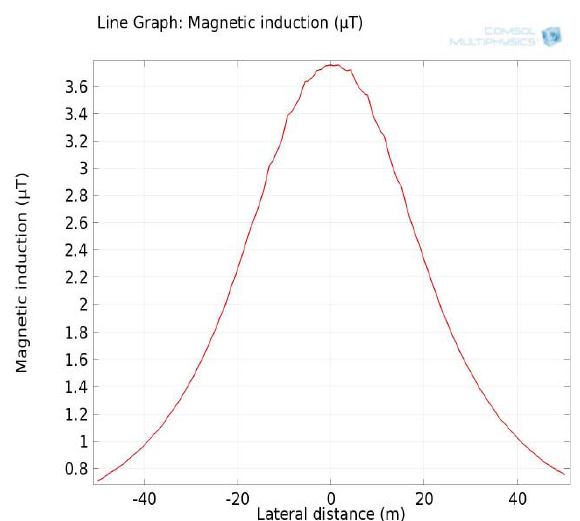
Figure 21: Magnetic induction profile at pylon foot at 1 m above ground level using COMSOL 4.3a software.